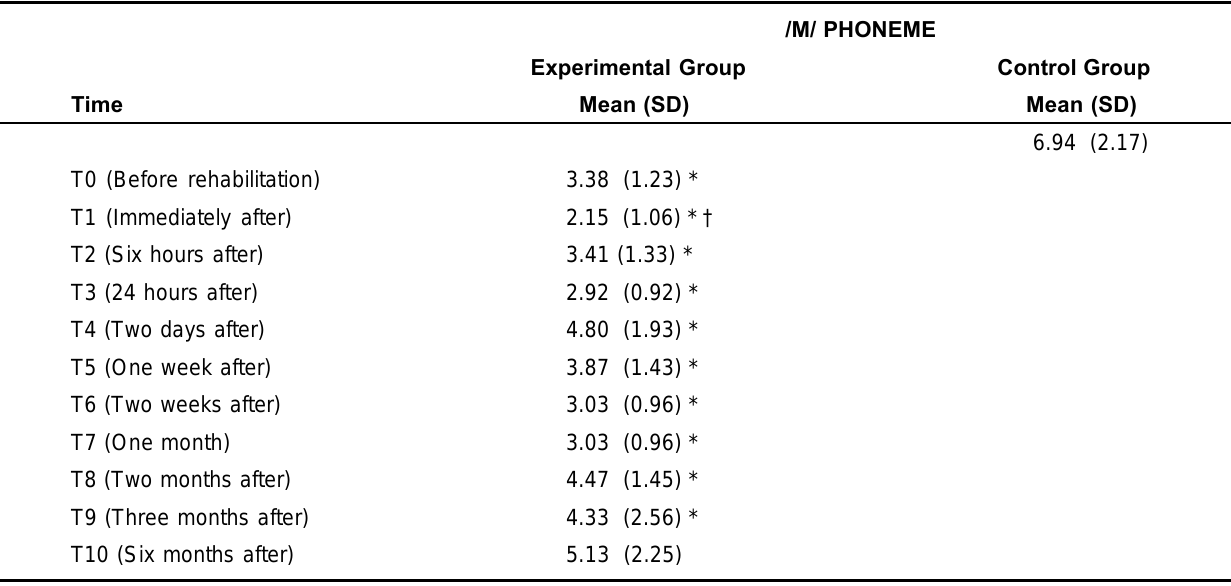
TABLE 1- Means and Standard Deviations of Interocclusal Distance (mm) During /m/ Sound Pronunciation, Before and After New Prosthesis Insertion.